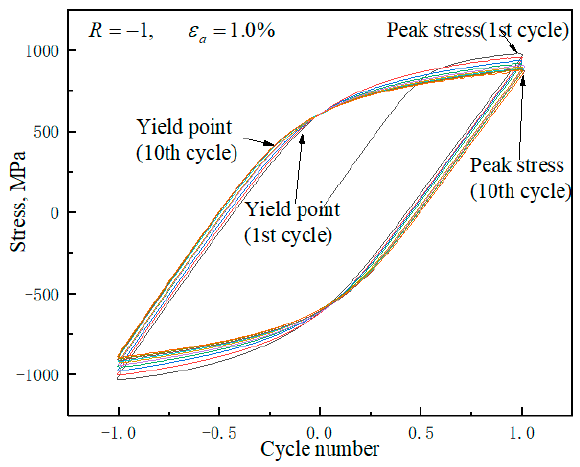
Figure 4. The hysteresis loops of the first 10 cycles.